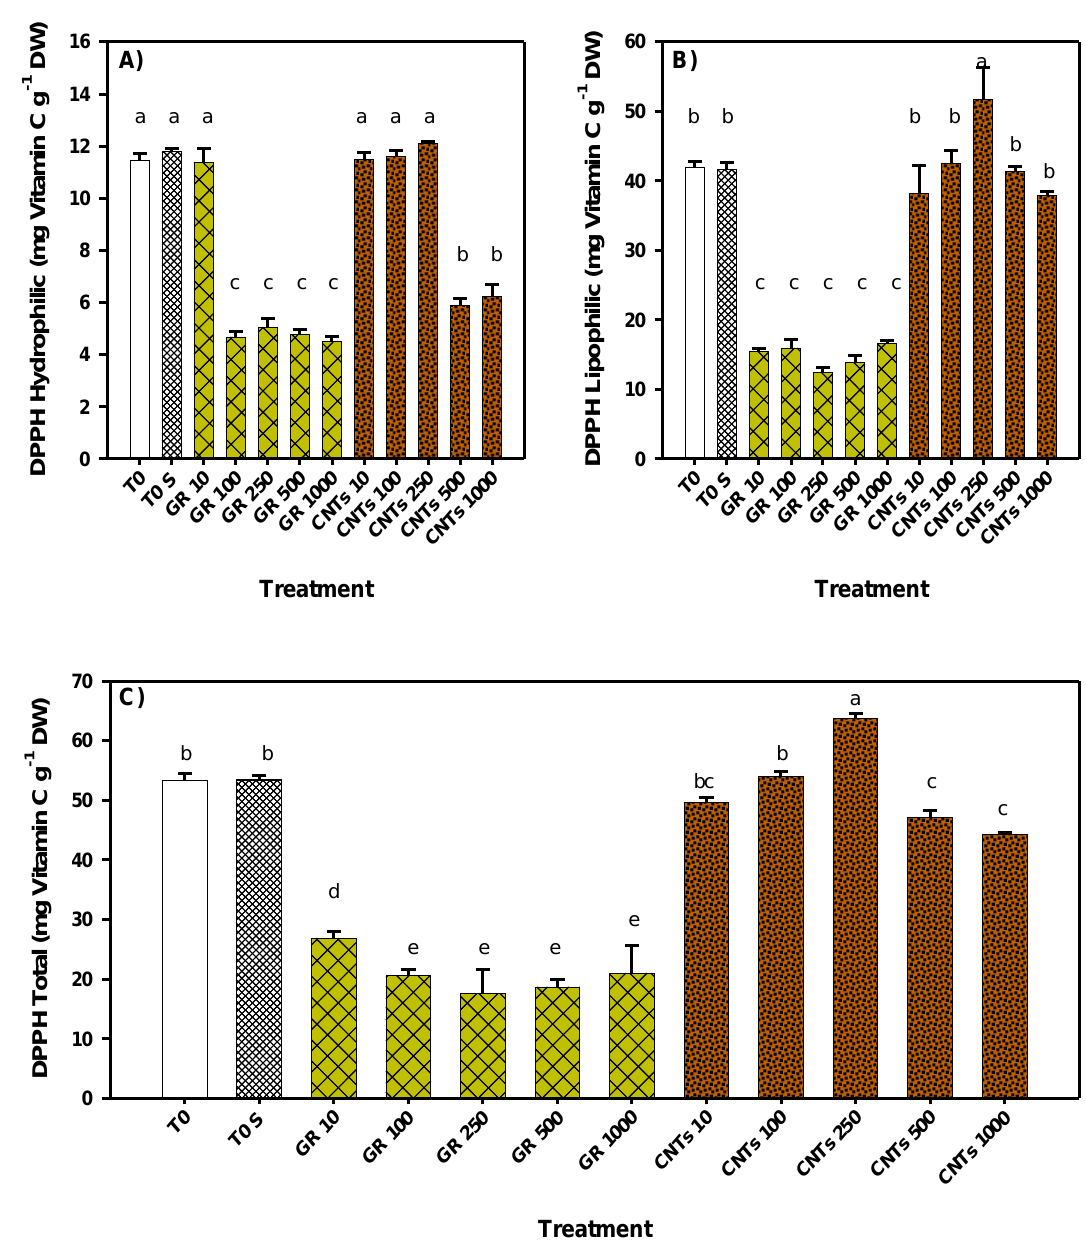
Figure 5. The antioxidant capacity determined in the leaves of tomato seedlings treated with carbon nanomaterials. Each data point is the average of five replicates ± standard error. Different letters indicate significant differences between treatments according to Fisher’s least significant difference test ( p ≤ 0.05). T0: absolute control. T0 S: sonicated control. GR: graphene. CNTs: carbon nanotubes. DPPH: 2,2-difenil − 1-picrilhidracilo (equivalents of vitamin C mg g − 1 DW). H: hydrophilic compounds. L: lipophilic compounds. DPPH Total: total antioxidant capacity.